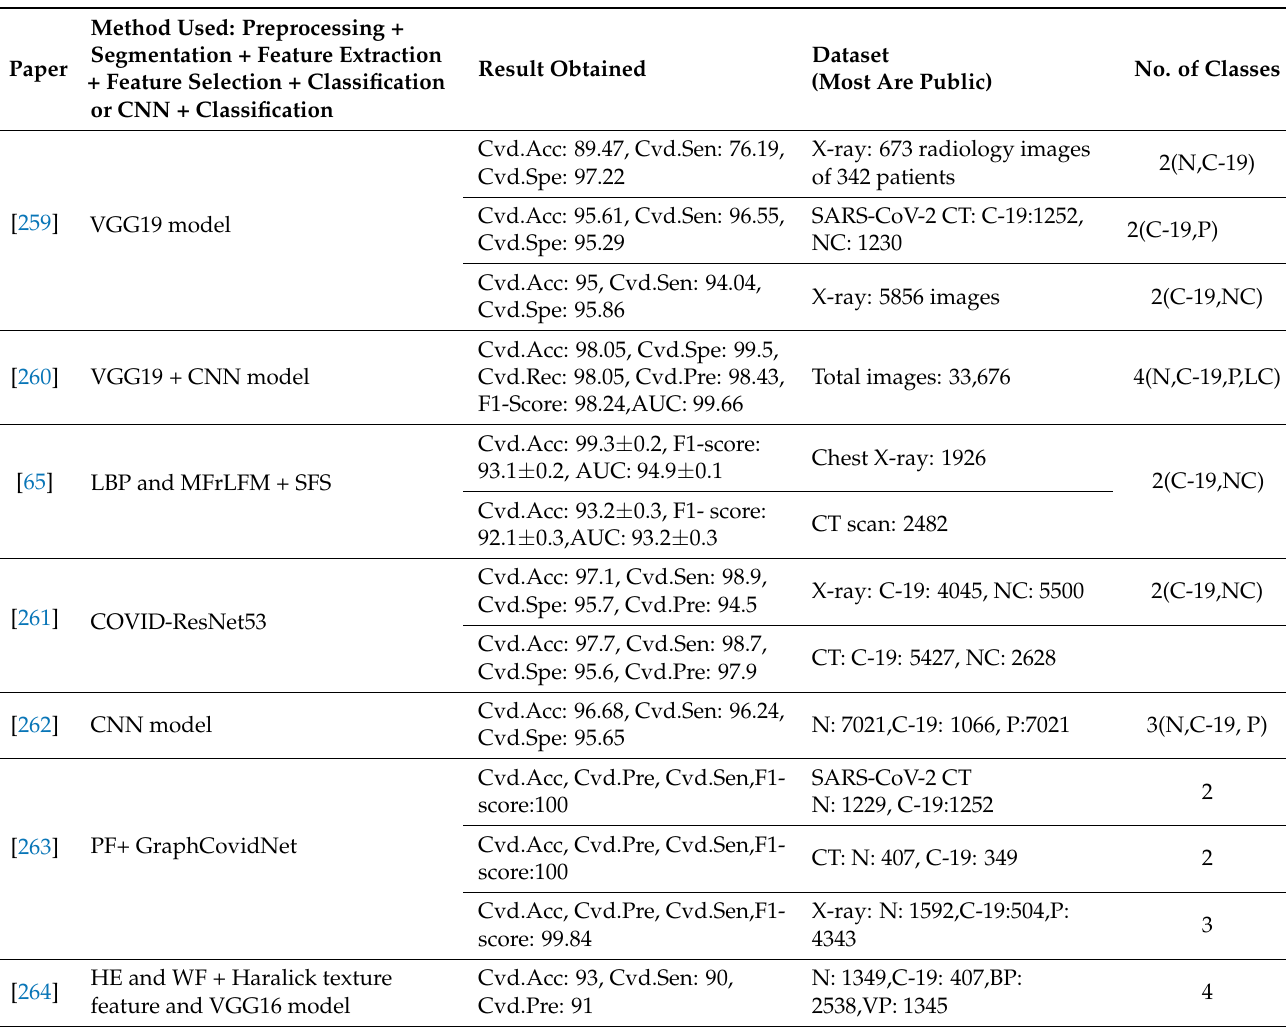
Table 5. State-of-the-art AI techniques to detect COVID-19 using X-ray and CT